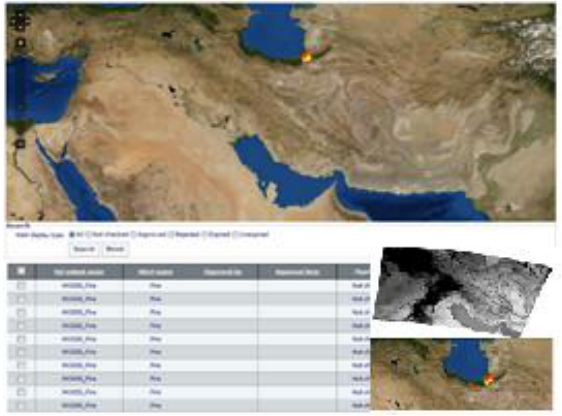
Figure 8. Visualization and alert confirmation section of fire event from MODIS